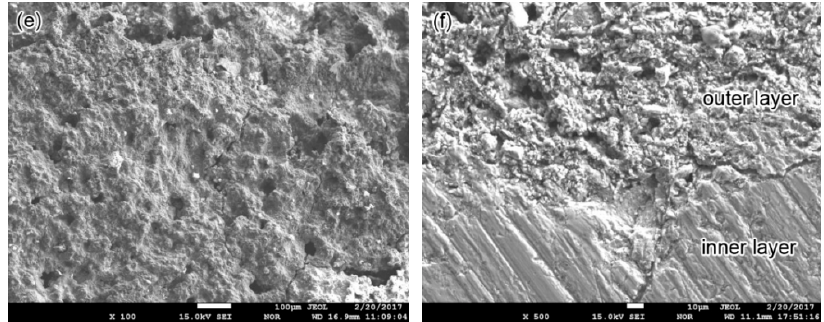
Figure 6. Top view ( a , c , e ) and cross-sectional view ( b , d , f ) of corrosion scales on steel pipes: ( a , b ) 2 ″ pipe, ( c , d ) 4 ″ pipe and ( e , f ) 6 ″ pipe.